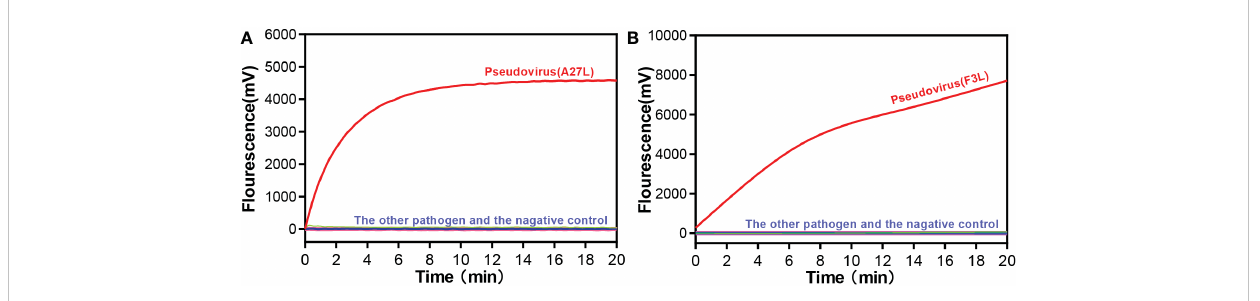
FIGURE 2 Speci fi city of the RAA assay for (A) A27L gene and (B) F3L gene of Mpox virus detection. Only the pseudovirus produced ampli fi cation signals, whereas the other pathogen samples and the negative control produced no ampli fi cation